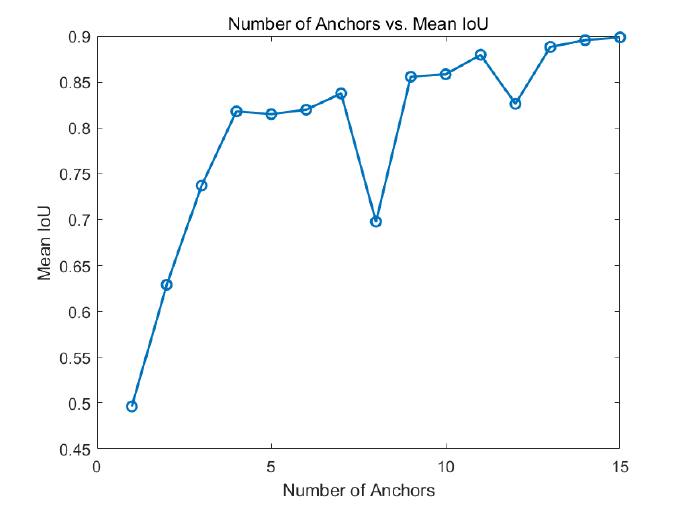
Figure 5. Effect of the number of anchors on the mean IoU.